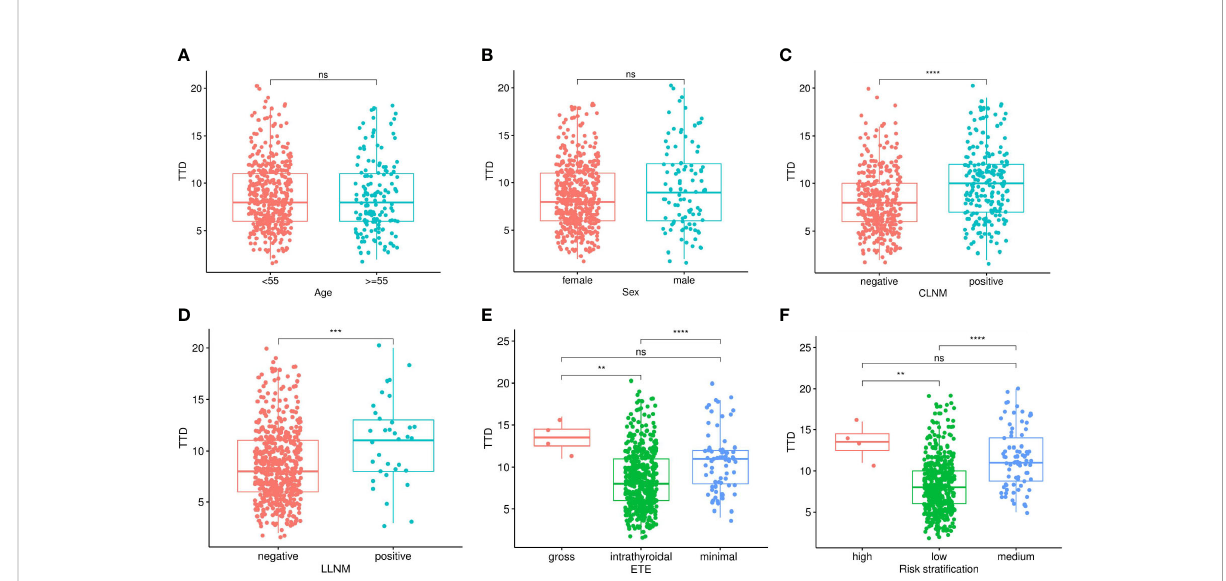
FIGURE 1 Relationship between TTD and clinicopathological features in multifocal PTMC, including Age (A) , Sex (B) , CLNM (C) , LLNM (D) , ETE (E) and Risk strati fi cation (F) . TTD, total tumor diameter; PTMC, papillary thyroid microcarcinoma; CLNM, central lymph node metastasis; LLNM, lateral lymph node metastasis; ETE, extrathyroidal extension. *P < 0.05; **P < 0.01; ***P < 0.001; ****P < 0.0001; ns, not signi fi